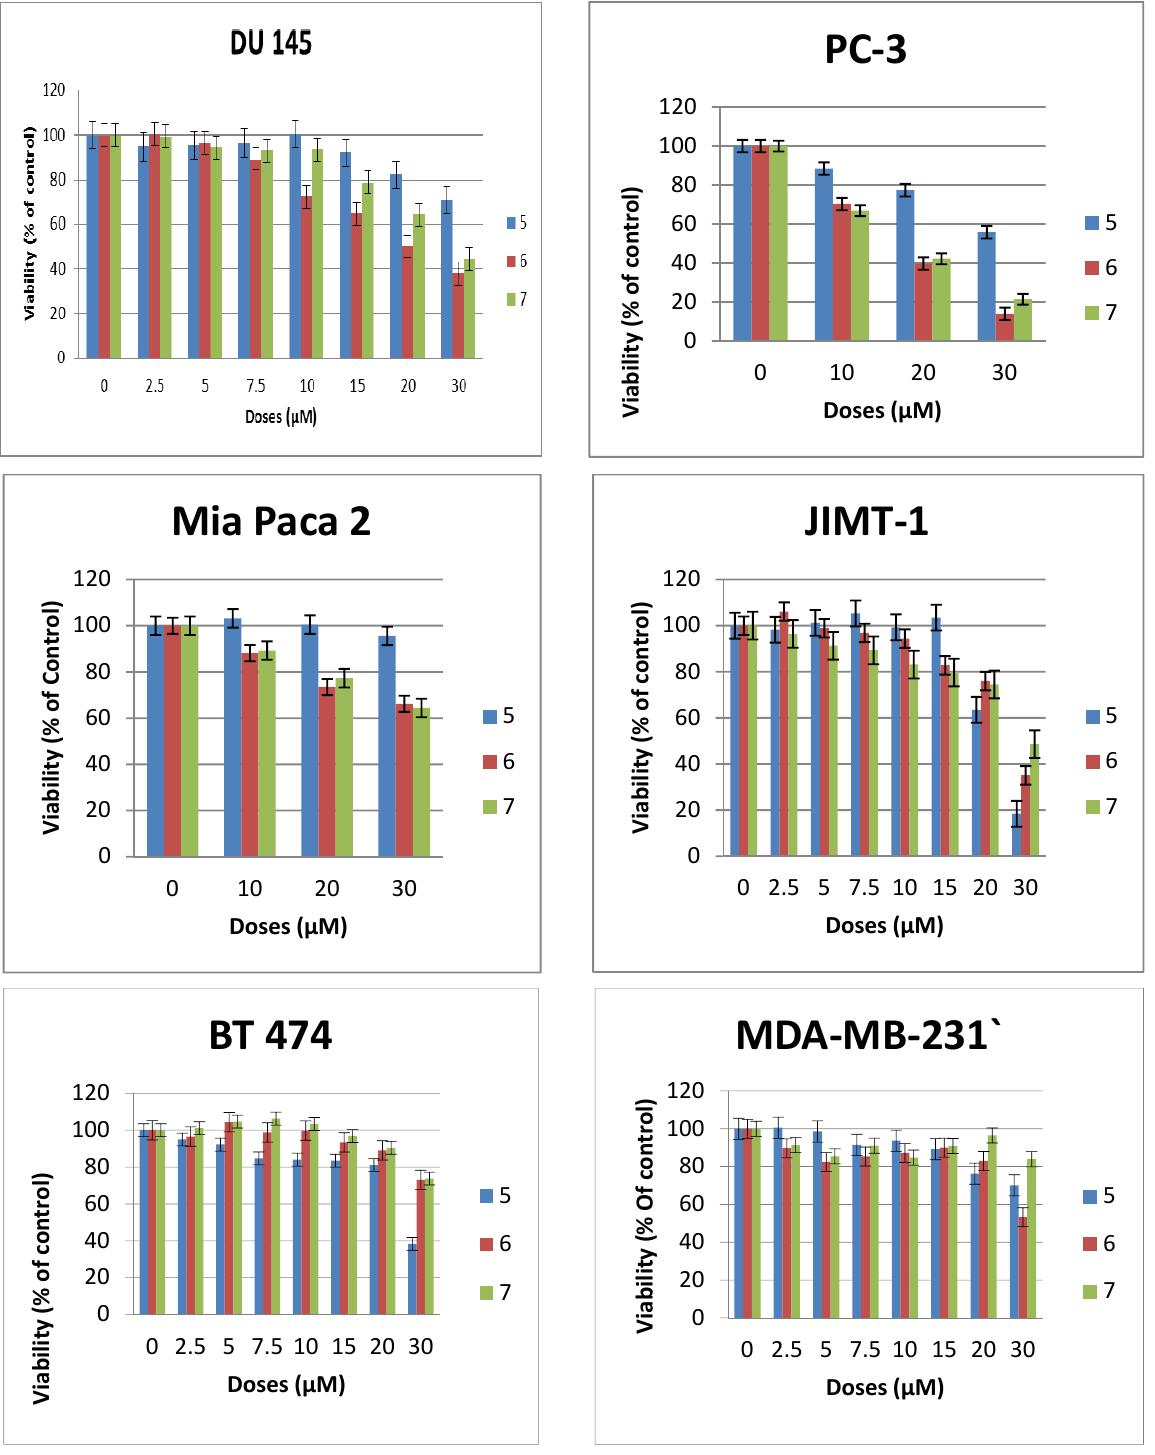
Figure 3. Effects of compounds 5 – 7 on the viability of epithelial cancer cell lines: breast (BT474, JIMT1, MDA-MB-231), prostrate (DU145, PC3), pancreas (MiaPaCa2). The results represent the means ± standard deviations of six independent